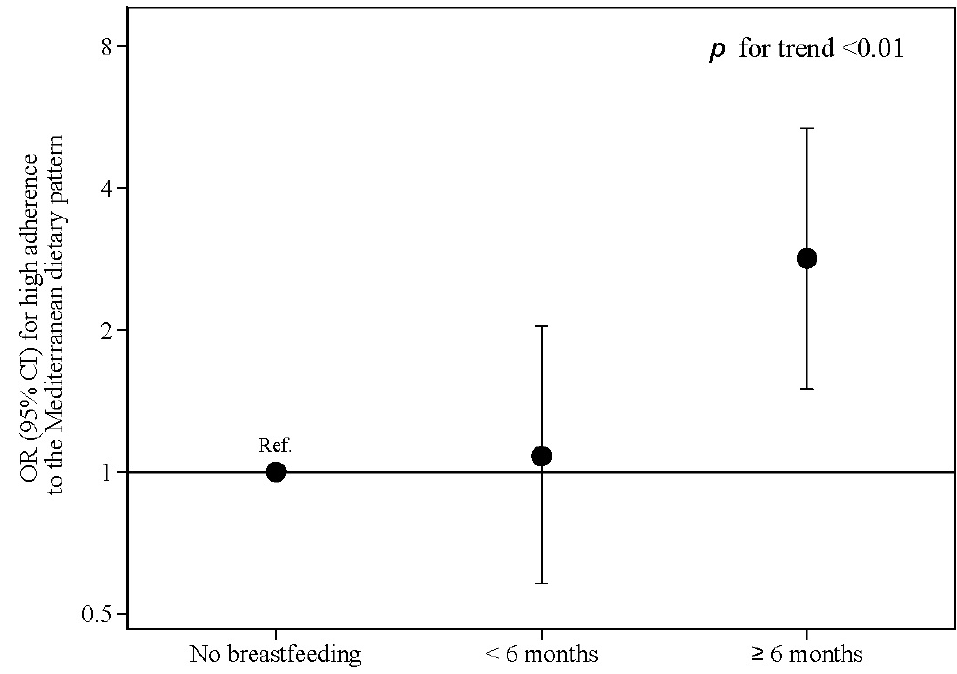
Figure 1. Odds ratio (OR) and 95% confidence interval (CI) for high adherence to the Mediterranean dietary pattern (KIDMED score ≥ 8) associated with breastfeeding history. The SENDO project. Table 3. Odds ratio (OR) and 95% confidence interval (CI) for high adherence to the Mediterranean dietary pattern (KIDMED score ≥ 8) associated with breastfeeding history. Breastfeeding Breastfeeding No Breastfeeding p for Trend ≥ 6 Months <6 Months